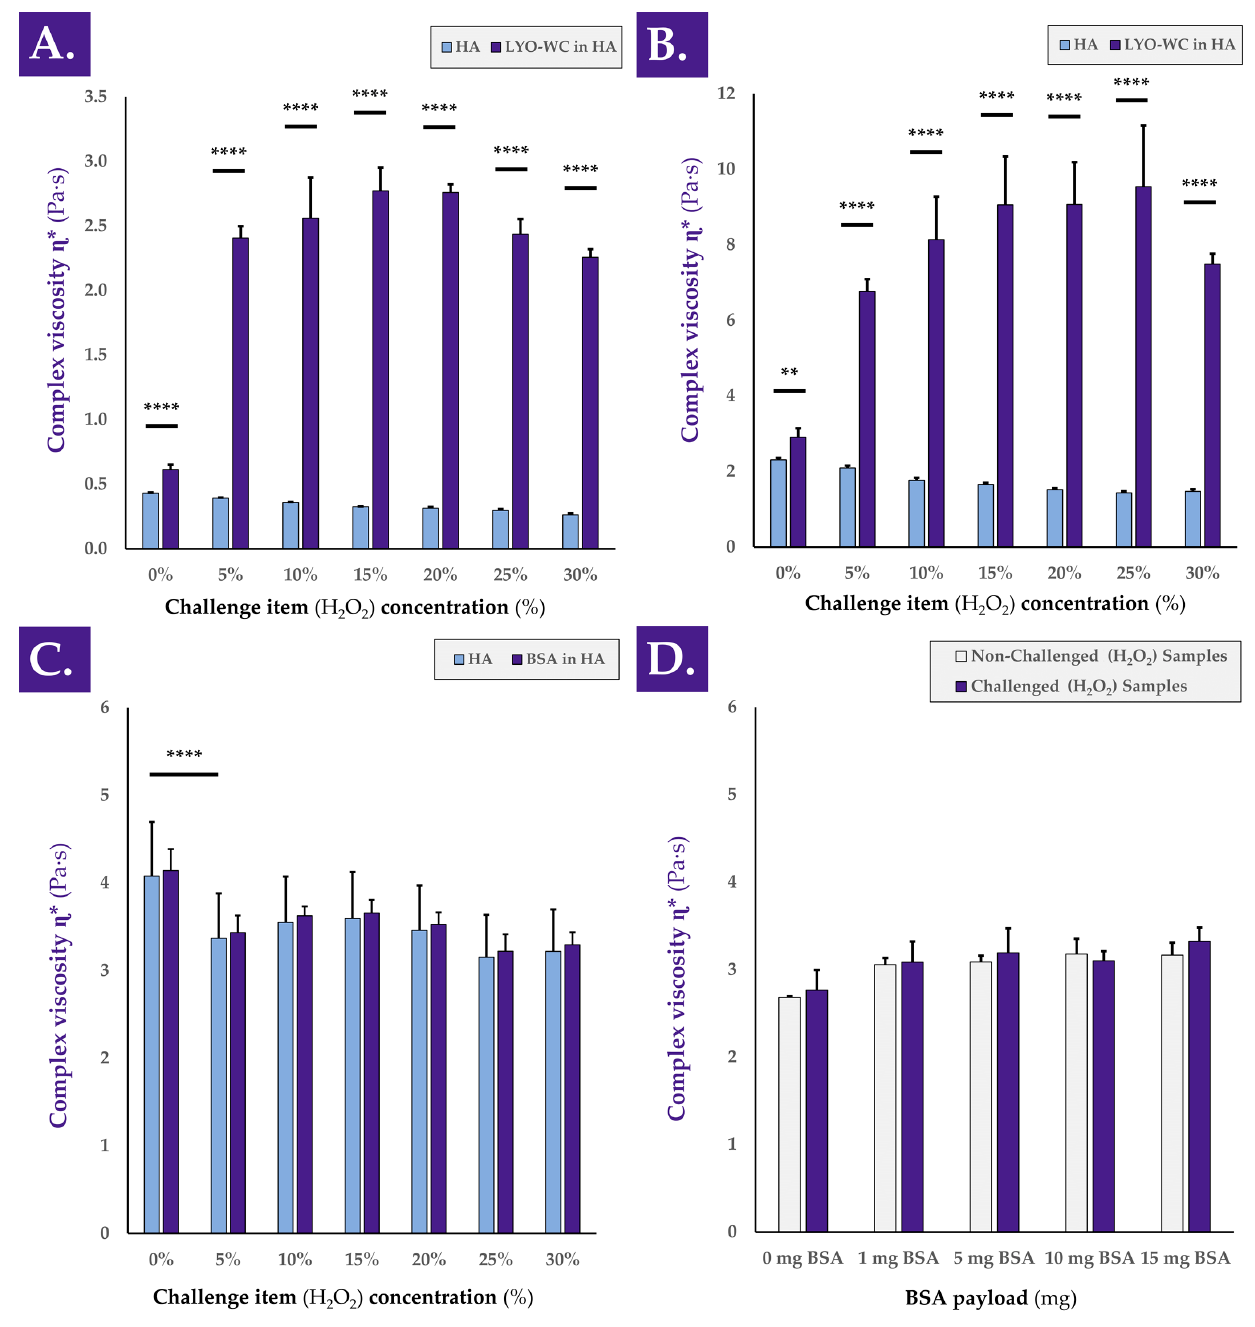
Figure 5. Rheological study of the behavior of various hydrogel samples under oxidative challenge. Complex viscosity η * of whole-cell samples resuspended in 1.0–1.25 MDa MW HA-based hydrogel ( A ) or in 2.2–2.4 MDa MW HA-based hydrogel ( B ) and challenged with various concentrations of H 2 O 2 . ( C ) Complex viscosity η * of samples containing a constant quantity of BSA suspended in a 2.2–2.4 MDa MW HA-based hydrogel and challenged with various concentrations of H 2 O 2 . ( D ) Complex viscosity η * of samples containing various quantities of BSA suspended in a 2.2–2.4 MDa MW HA-based hydrogel and challenged with a constant quantity of H 2 O 2 (i.e., 30% w/w ). Very significant (i.e., ** or 0.001 < p value < 0.01) or extremely significant (i.e., **** or p value < 0.0001) were found between mean values. BSA, bovine serum albumin; HA, hyaluronic acid; LYO-WC, lyophilized whole-cell fraction; MDa, megaDalton; MW, molecular weight; Pa · s, Pascal seconds.